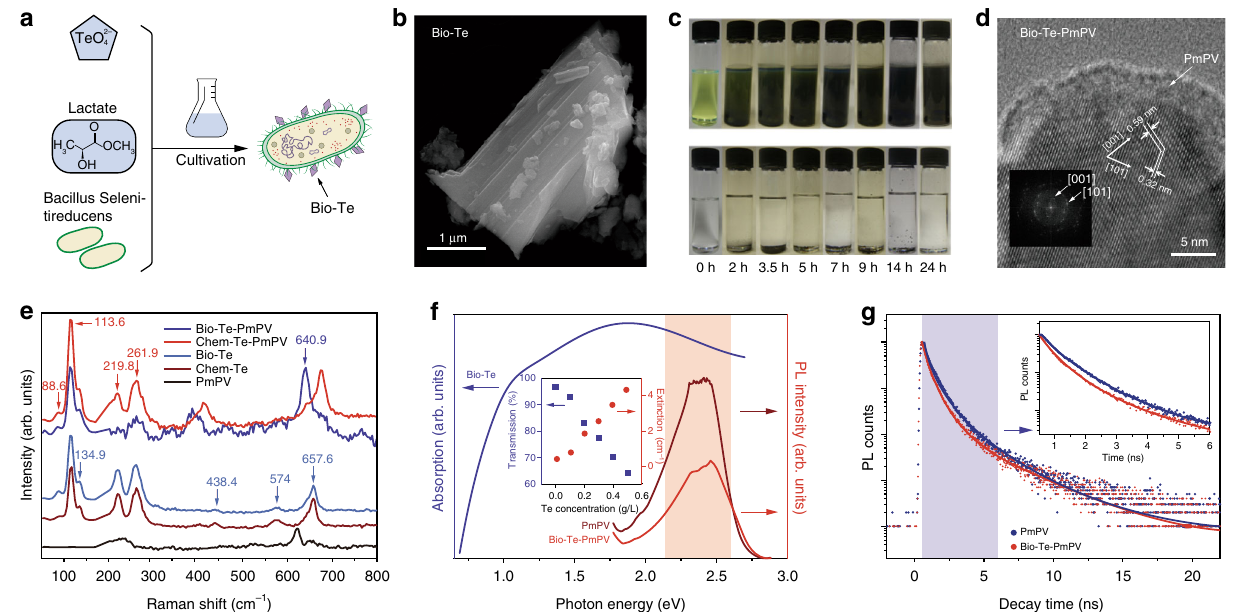
Fig. 1 Synthesis and characterization of biological synthesized tellurium (Bio-Te). a Synthesis scheme of tellurium nanocrystals by anaerobic bacteria, Bacillus selenitireducens . b Image of Bio-Te crystalline nano- fl ake taken by scanning transmission electron microscope. c Dispersion of Bio-Te in PmPV/ toluene (upper) and in toluene only (bottom) with increasing stirring times on the X-axis, showing the preparation of Bio-Te-PmPV composites. PmPV is abbreviation of poly( m -phenylenevinylene)- co -2,5-dioctoxy-phenylenevinylene. d Transmission electron microscopy image of a Bio-Te crystalline nano- fl ake wrapped by PmPV layers. Inset is the image after fast Fourier transformation (FFT). e Raman spectra of Bio-Te, Bio-Te-PmPV, chemically synthesized tellurium nanocrystals (Chem-Te), Chem-Te-PmPV, and PmPV. f Left: the absorption spectrum of Bio-Te. This curve was obtained by subtracting the absorption of PmPV (0.5 g/L in toluene) from that of Bio-Te-PmPV. Right: photoluminescence (PL) spectra of Bio-Te-PmPV and pure PmPV. Inset: optical linear transmission and extinction coef fi cient as functions of Te concentrations at 532 nm. g The PL decay kinetics of PmPV and Bio-Te-PmPV at 528 nm excitation. The inset shows a blow up of the blue shaded region, showing the quenching effect caused by tellurium